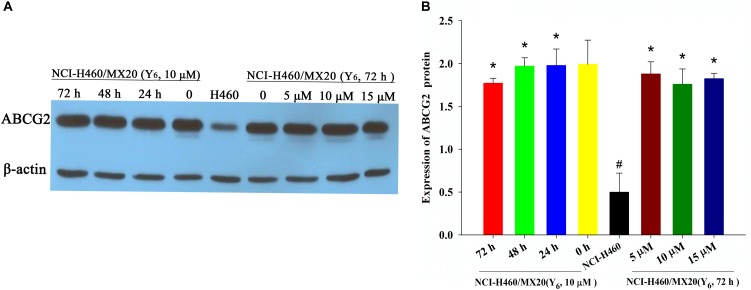
(A) The expression of ABCG2 in NCI-H460 and NCI-H460/MX20 cells with different treatments. Effect of Y6 at 10 μM on expression levels of ABCG2 in NCI-H460 and NCI-H460/MX20 cells at 0, 24, 48, and 72 h; or 0, 5, 10, 15 μM of Y6 after incubation for 72 h. (B) Quantified ABCG2 expression in NCI-H460 and NCI-H460/MX20 cells with different treatments. Values represent means ± SDs of at least three independent experiments performed in triplicate; ∗p > 0.05 vs. the NCI-H460/MX20 cells without treatment on the ABCG2 protein; #p < 0.05 vs. the NCI-H460/MX20 cells without treatment on the ABCG2 protein.